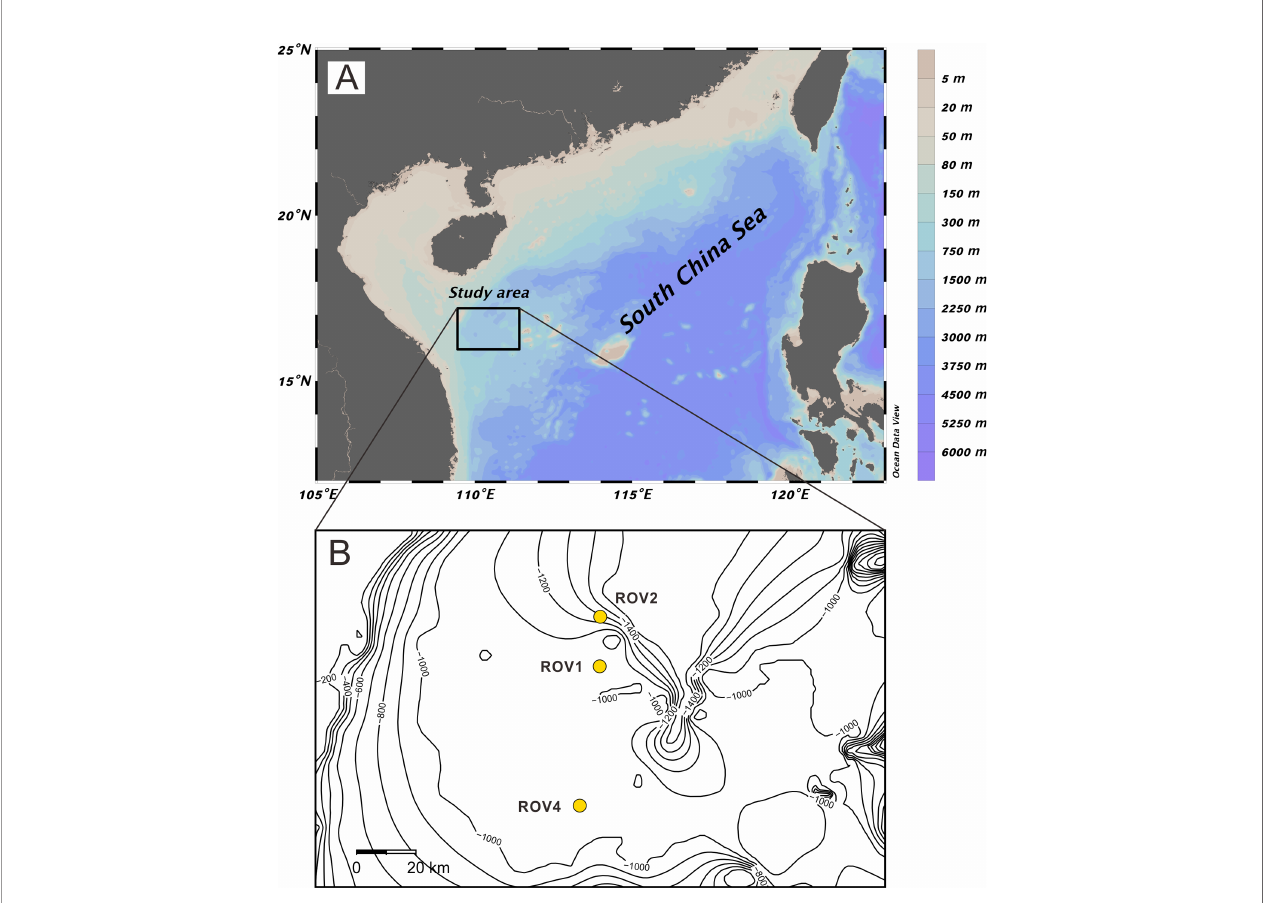
FIGURE 1 | Map showing the location of study area (Schlitzer, Reiner, Ocean Data View, https://odv.awi.de, 2021) (A) and sampling sites (B)